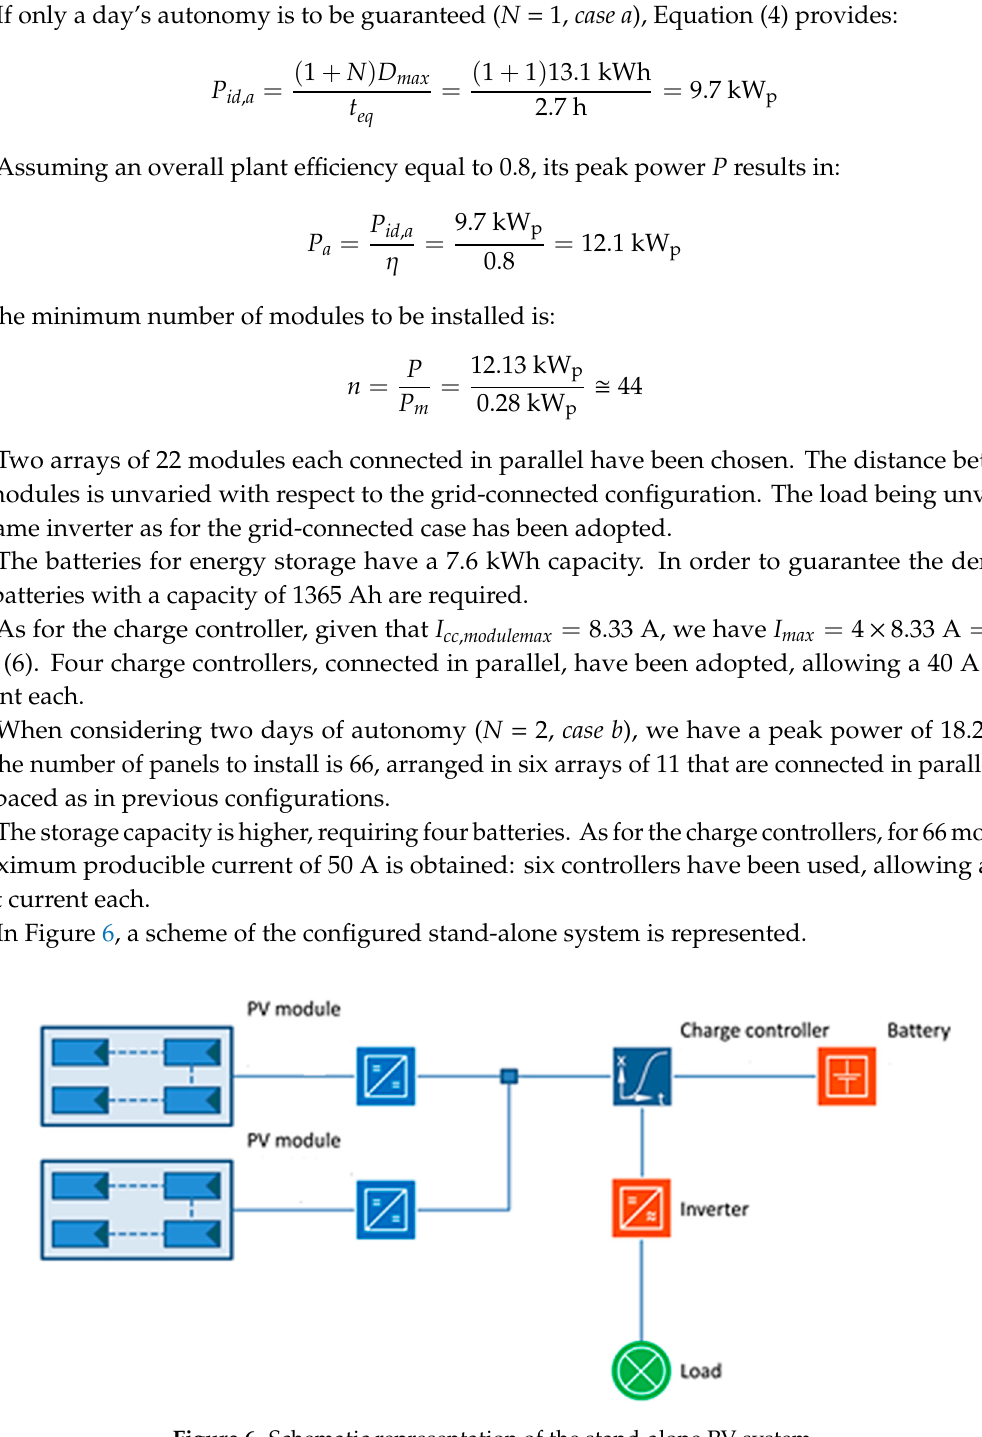
Figure 6. Schematic representation of the stand-alone PV system.